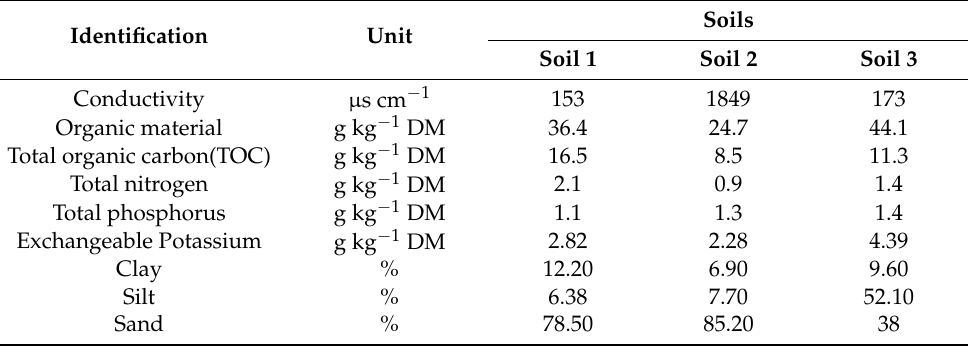
Table 1. Content of organic material, total organic carbon, total nitrogen, total phosphorus, Ex- changeable potassiumand percentage of particle size fractions in the investigated soils samples: Soil 1—Korba, Soil 2—Korba saline, Soil 3—SolimanDhari. % [per 100 g of dry